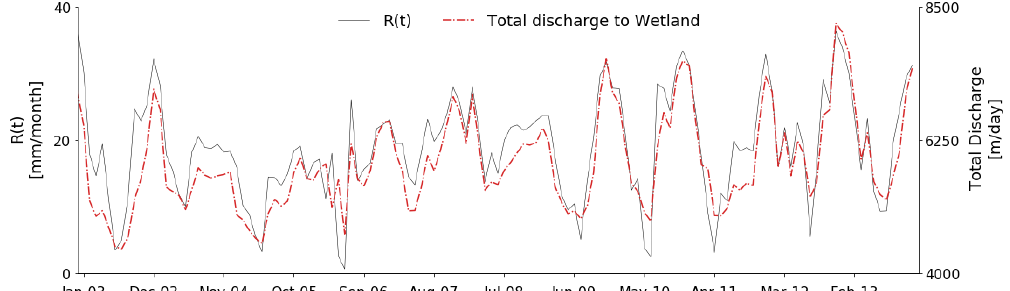
Figure 11. Simulated total groundwater discharge and monthly average groundwater recharge.